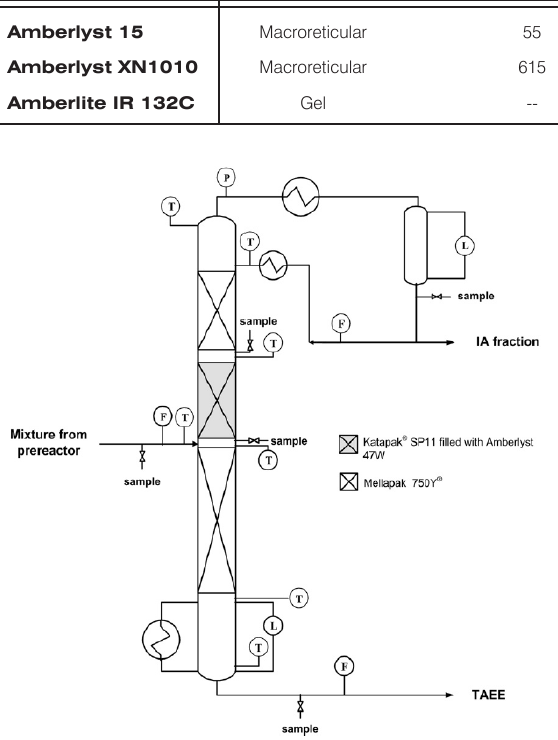
Figure 13. Experimental setup for TAEE synthesis from EtOH and FCC gasoline. F (flow), P (pressure), T (temperature), L (liquid tank level) [40].